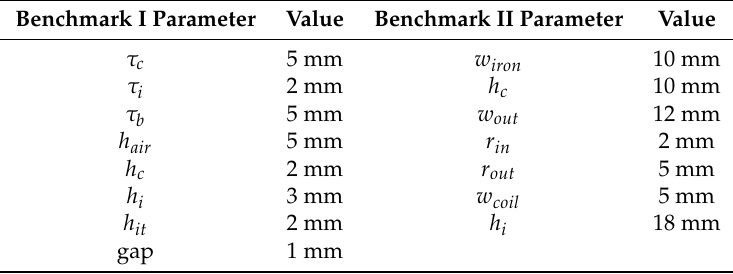
Table 1. Parameters for Benchmarks I and